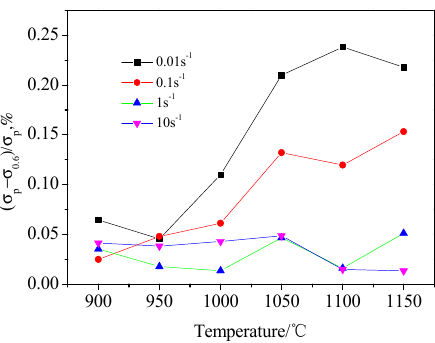
Figure 2. The extent of the flow softening ( ∆ σ / ∆ p , ∆ σ = σ p − σ 0.6 ) as a function of deformation temperature at various strain rates.